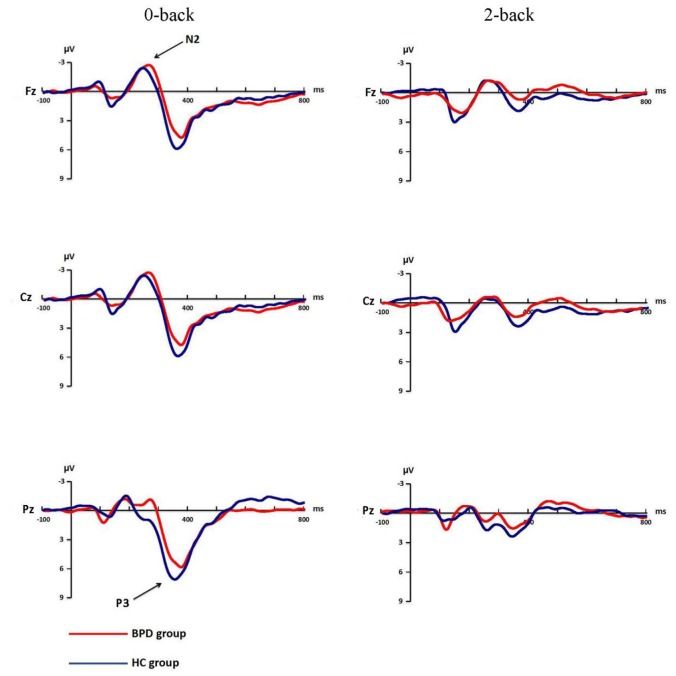
Grand-average ERP waveforms of N2, P3 for 0-back and 2-back in BPD and HC groups. The electrodes of Fz, Cz and Pz were chosen to record N2 and P3. N2 and P3 changed under 0-back and 2-back in both groups.